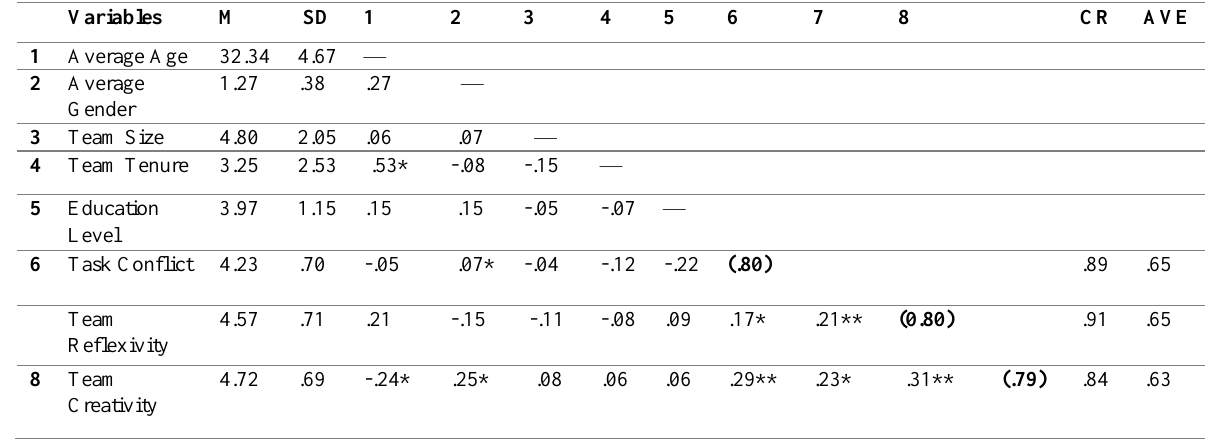
Table 2: Means, standard deviations, correlations, composite reliability, and average variance extracted